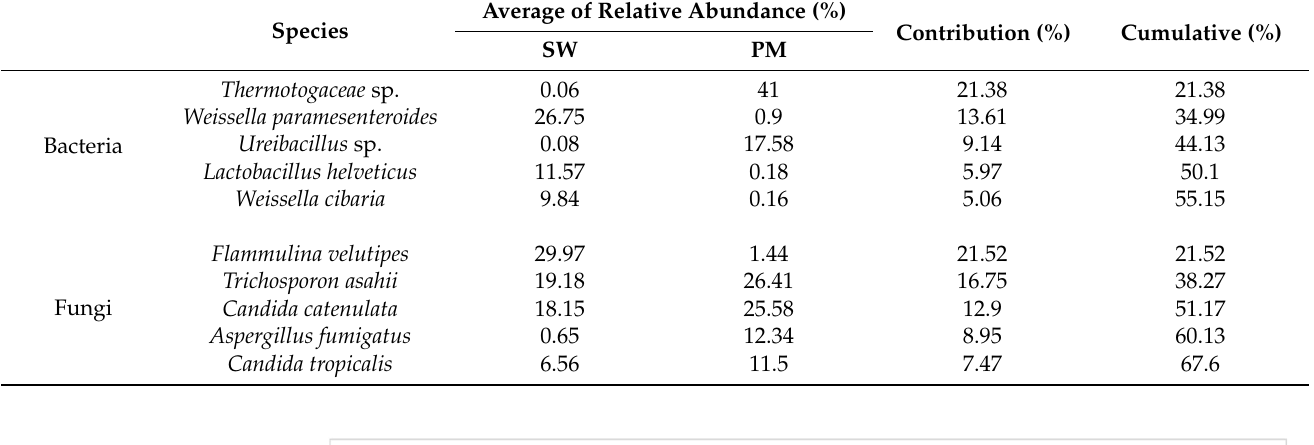
Table 2. Similarity percentage (SIMPER) analysis showing the five most influential species that con- tribute to the difference in the bacterial or fungal community structure between the spent mushroom substrate with addition of soy wastes (SMS-SW) and swine and poultry manure (SMS-PM). Average of Relative Abundance (%) Species